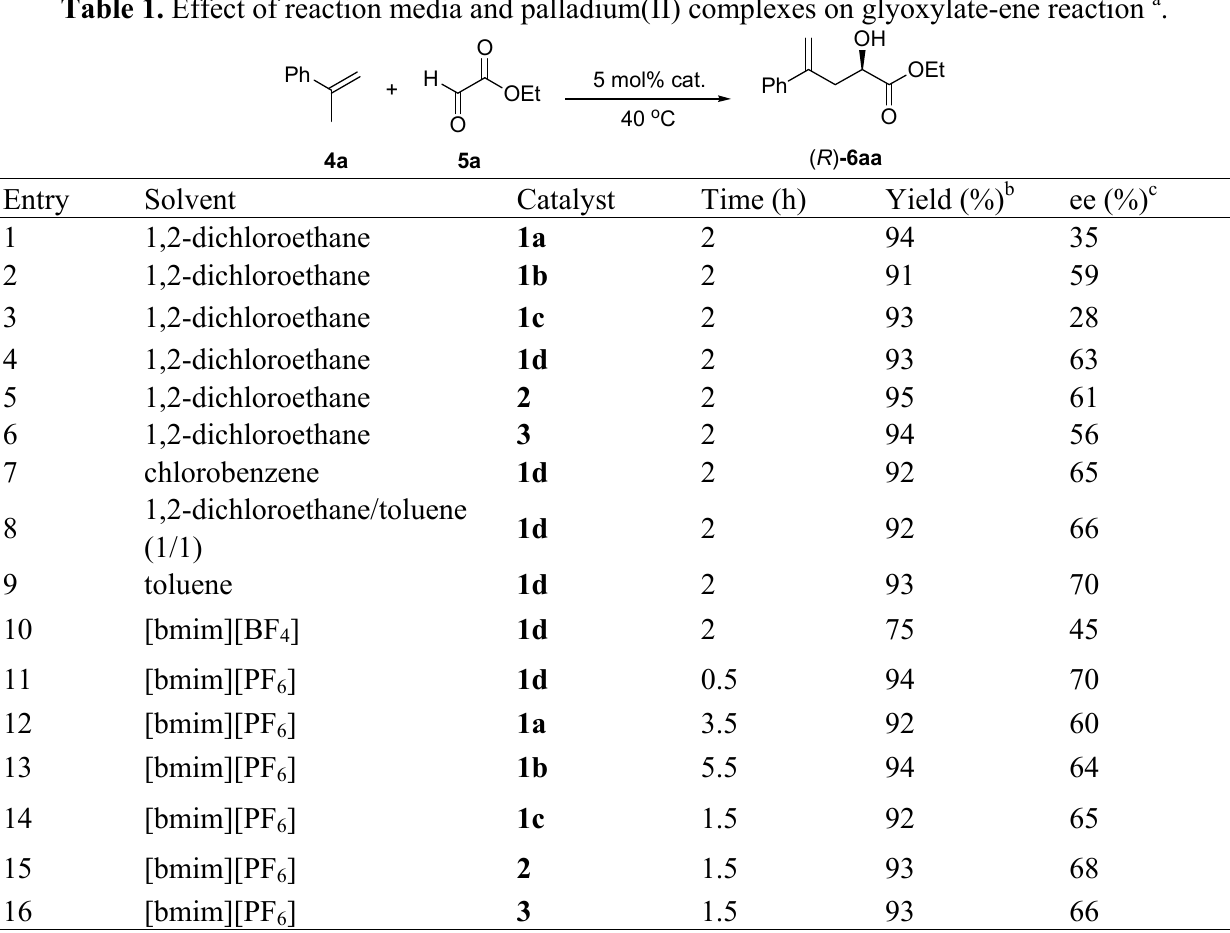
Table 1. Effect of reaction media and palladium(II) complexes on glyoxylate-ene reaction a . O OEtPh 5 mol% H + O